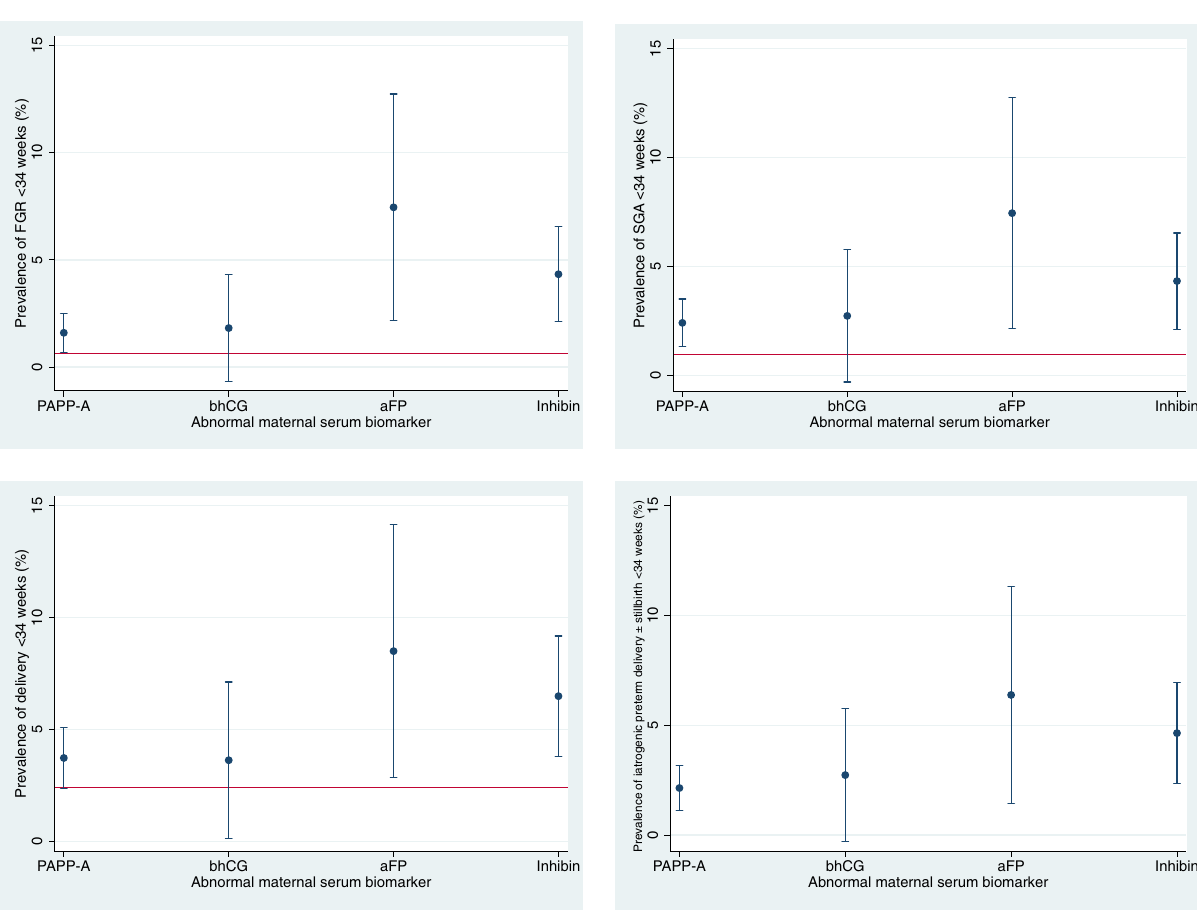
Figure 2. The risk of adverse pregnancy outcomes < 34 weeks associated with different abnormal serum biomarkers. The red horizontal lines indicate the background incidence of each outcome. *Background prevalence of iatrogenic delivery < 34 weeks and stillbirths without congenital anomaly were not reliably coded in electronic health records and therefore has not been included. Illustrated as proportions and 95% confidence